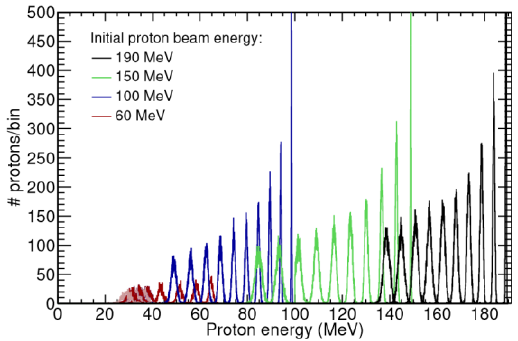
Figure 2 . Proton energy distribution for the PE assembly. Note that in the case of the 60 MeV irradiation, a 100 MeV proton beam was degraded using 40 mm of polyethylene. In this case, the different intensities of red colour is used to distinguish between consecutive